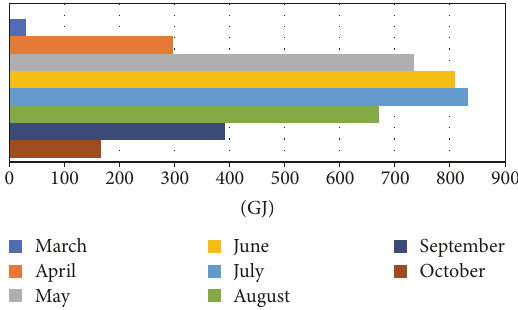
Figure 16: Fluctuation of oil mass fl ow in arrays at sunny